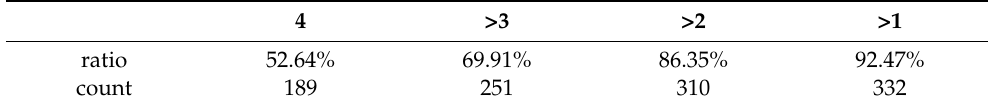
Table 5. The ratio and count of actual representative spatio-temporal documents to be judged as representative spatio-temporal documents according to workers.